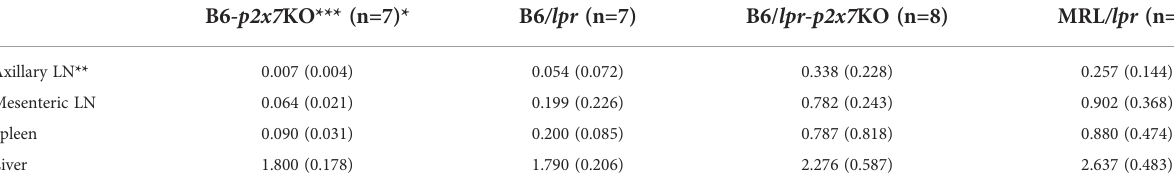
TABLE 1 Organ weights of B6/ lpr-p2x7 KO mice compared to parental strains and MRL/ lpr mice.